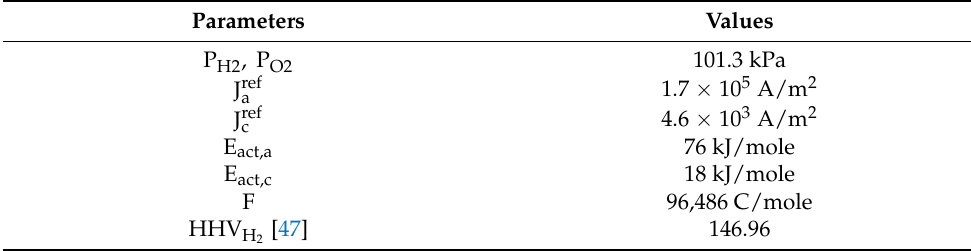
Table 5. Input parameters used in PEM